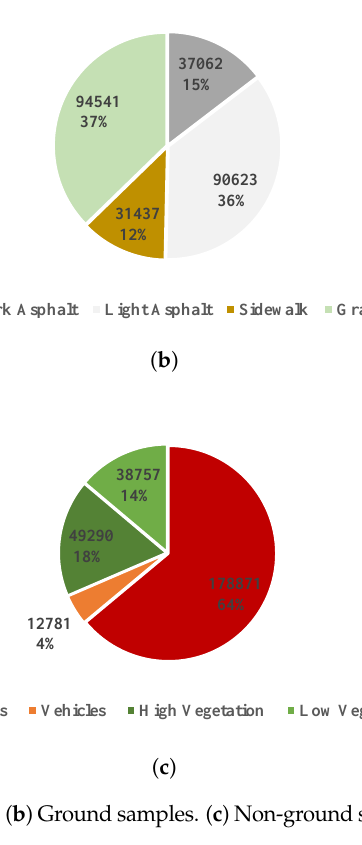
Figure 9. Distribution of training data. ( a ) Ground samples. ( b ) Non-ground samples.